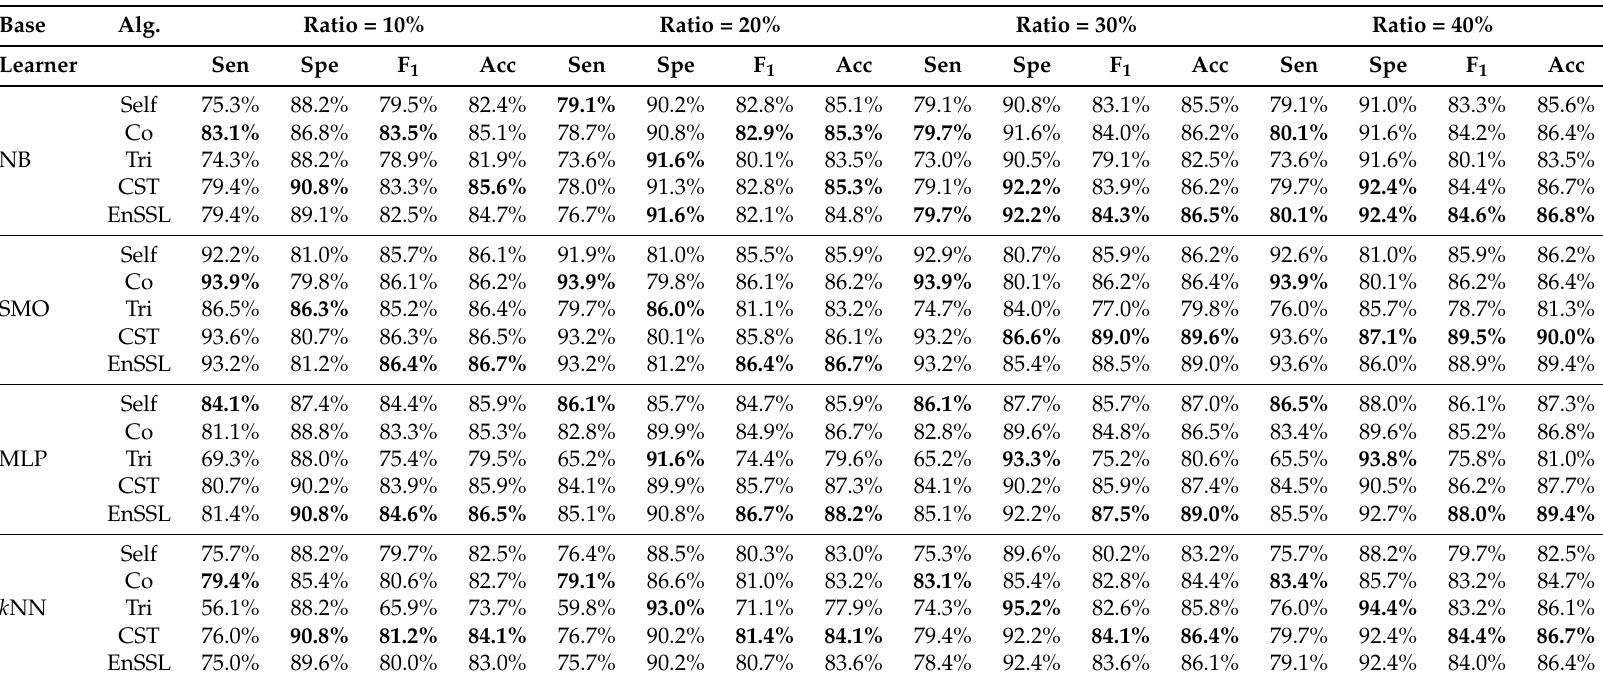
Table 3. Performance evaluation of Self-training, Co-training, Tri-training, CST-Voting and EnSSL on the Japanese credit